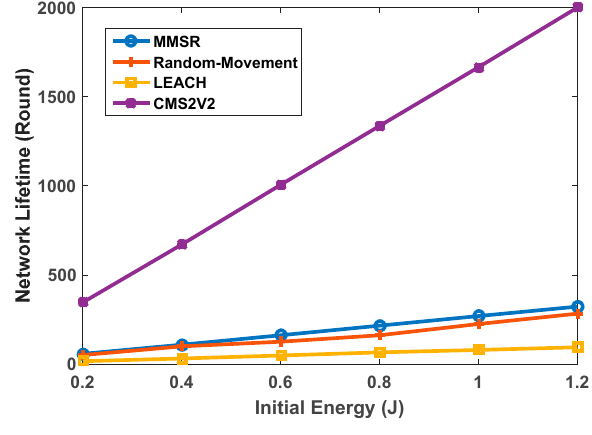
Figure 9. Network lifetime.